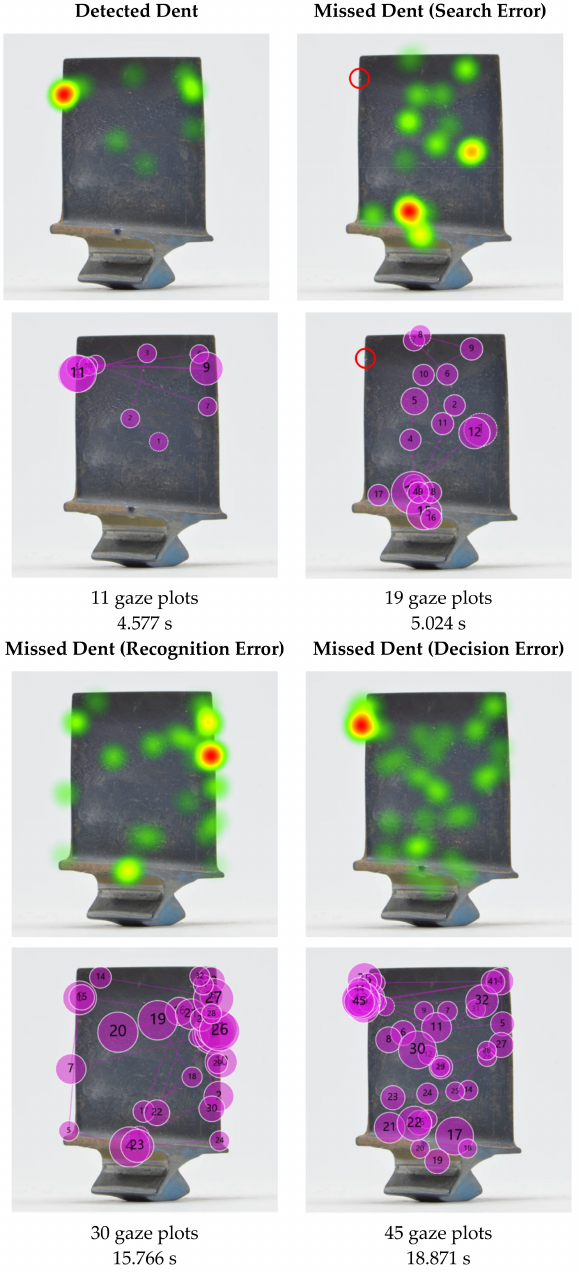
Figure 20. Blade with dent on the trailing edge (indicated by red circle). Heat maps and gaze plots were created, highlighting the different inspection